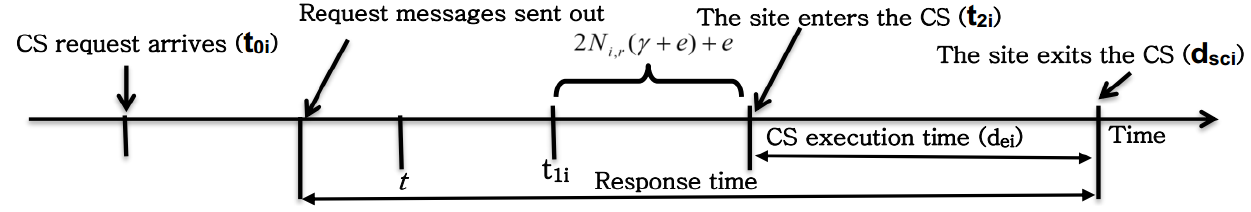
Figure 1: Description of urgency of